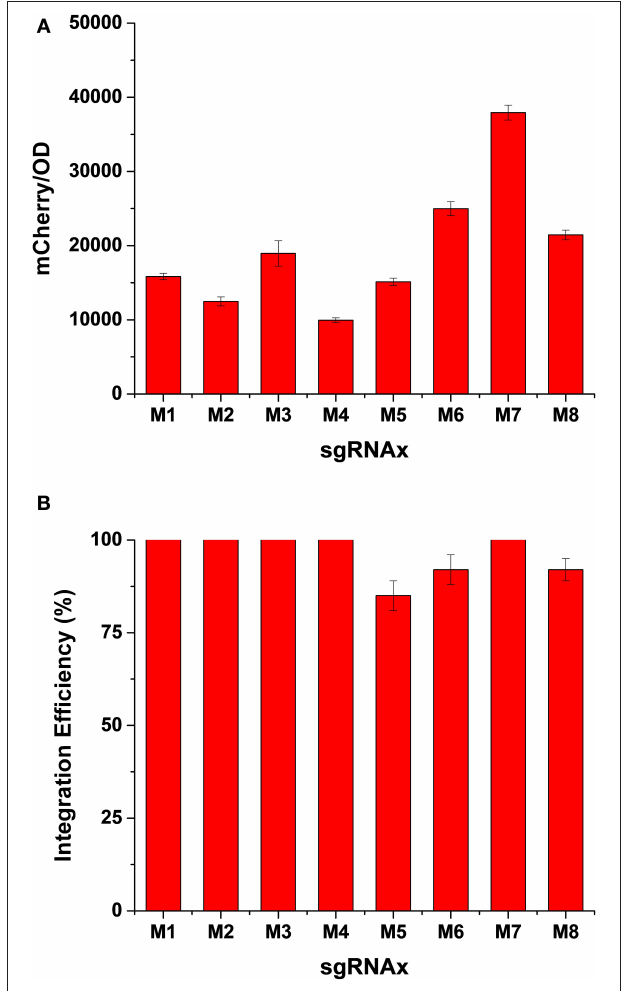
FIGURE 2 | Evaluation of expression level (A) and integration efficiency (B) of heterologous genes in different genomic loci of the expression chassis. The integration efficiency was calculated as number of colonies with mCherry fluorescence/total number of colonies tested. Error bars represented the mean ± s.d. of biological